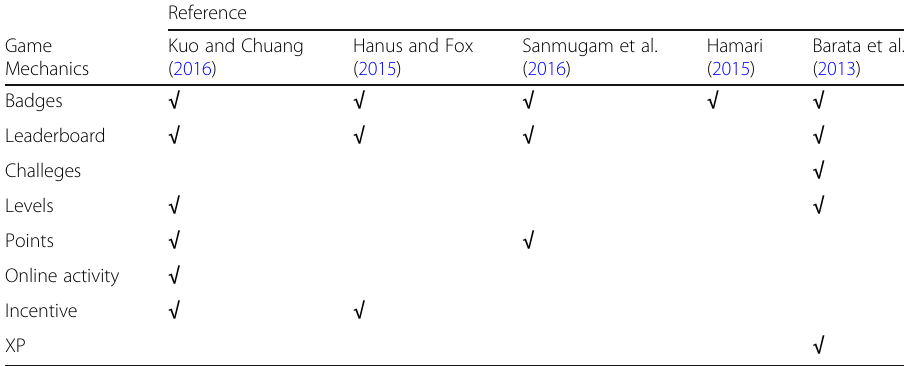
Table 1 Comparison of Game Elements used in previous